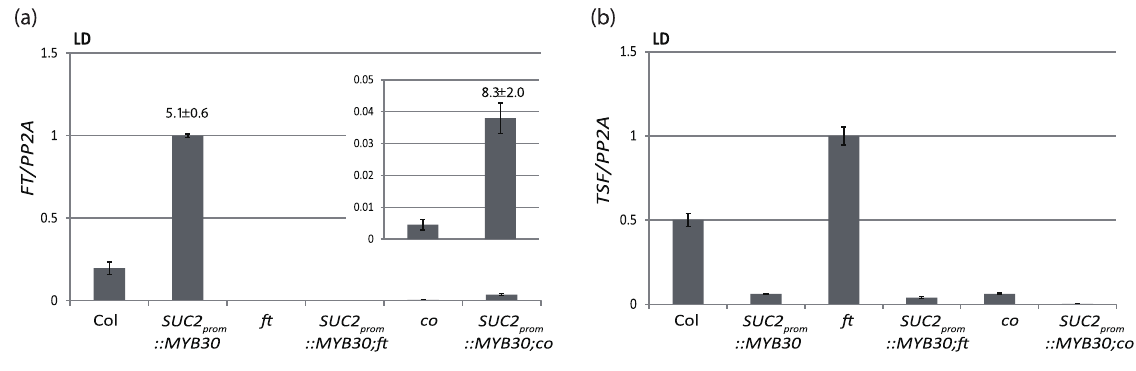
Figure 5. Expression of FT and TSF in WT, ft and co plants. Material from 13-day-seedlings grown on soil in LDs in the greenhouse was collected at ZT16. FT ( a ) and TSF mRNA ( b ) levels were determined by RT-qPCR in different genotypes as indicated. Insert in ( a ) shows values for co and SUC2 prom ::MYB30;co at a lower scale. Fold-change FT expression in the SUC2 prom :: MYB30 lines compared to the respective control is indicated above the bar. Values are shown as Mean 6 SD after normalization of expression with values obtained for PP2A . Experiments were repeated twice with similar results.